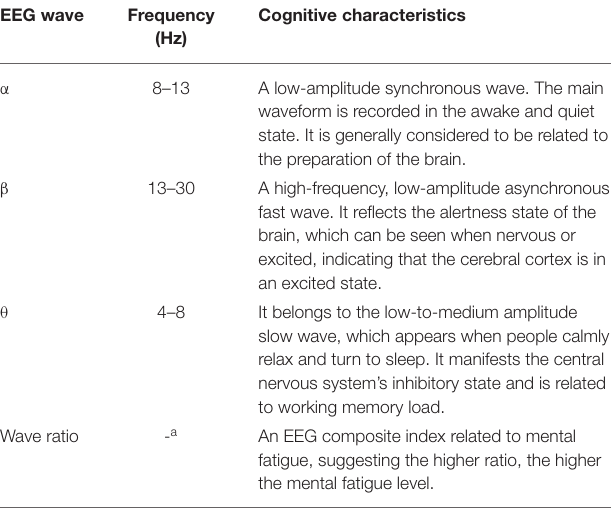
TABLE 1 | Characteristics of three types of electroencephalogram (EEG) rhythms and a composite index.